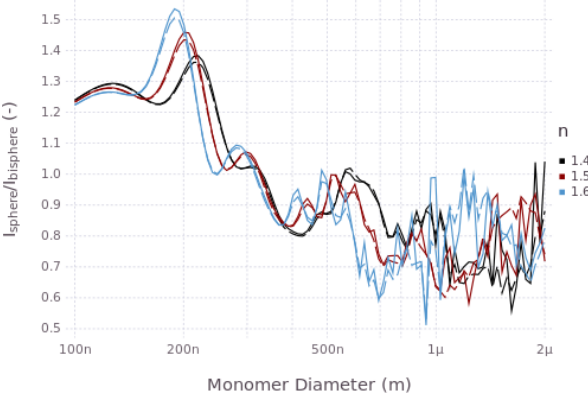
Figure 4. The intensity ratio of the uncoalesced bisphere particle and equivalent spherical particle as a function of monomer diame- ter and refractive index. Each line corresponds to a refractive index m = n + k i, where n is the real and k is the imaginary part. Colors correspond to variations in n. Solid lines correspond to k = 0, and dashed lines correspond to k = 0 .